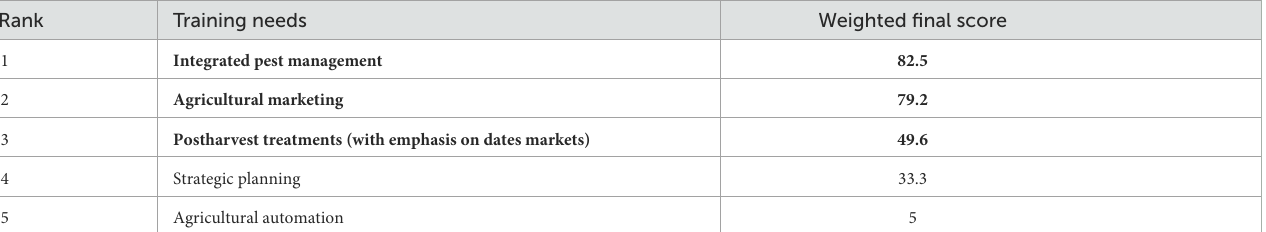
TABLE 5 The prioritized adaptive agribusiness training needs of the investigated mixed-in-one four brokers and exporters of produce group representing the four geographic regions of the Valley (sorted ascending; the top three training priorities for each group marked in bold in the far-right column). One mixed brokers and exporters of produce focus group representing the four geographic regions of the valley